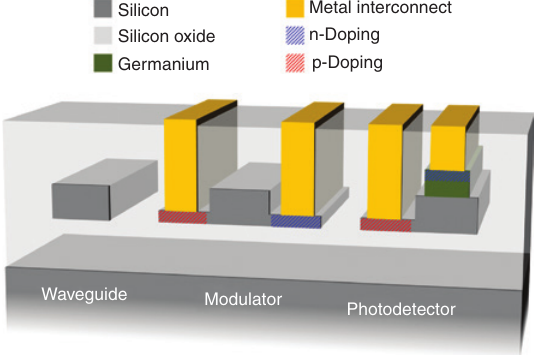
Figure 2: Schematic of components in silicon photonics technol- ogy. The components can be fabricated on a silicon substrate, using CMOS-compatible processes and processing infrastructure. The silicon waveguide confines and guides light. Electrical contacts on the modulator waveguide allow for carrier injection or depletion, a phase or amplitude modulator. The photodetector waveguide has a germanium layer, which absorbs the light. Carriers are generated upon absorption, which are detected as an electrical current.